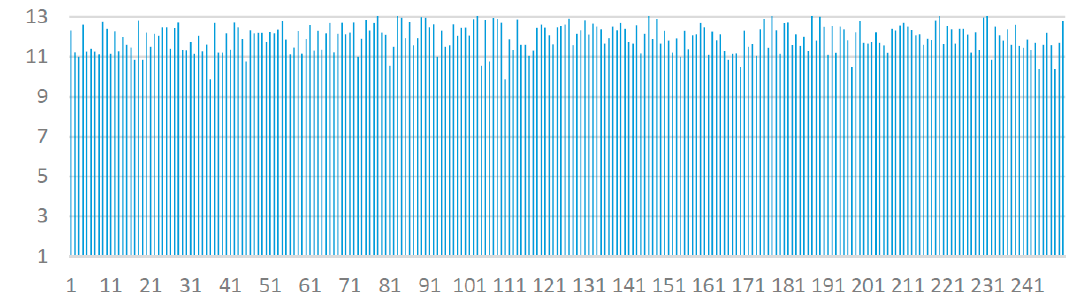
Figure 2. Minimum distances between points in 250-point optimal Latin hypercube DoE (Design of Experiments).